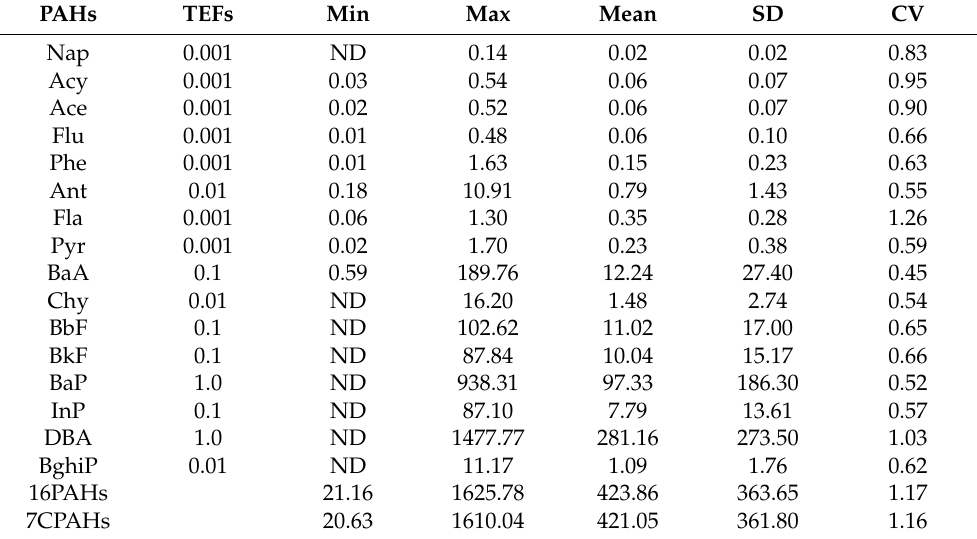
Table 7. Toxic equivalence quantities (TEQs) of PAHs in urban soil in Xi’an ( µ g/kg). PAHs